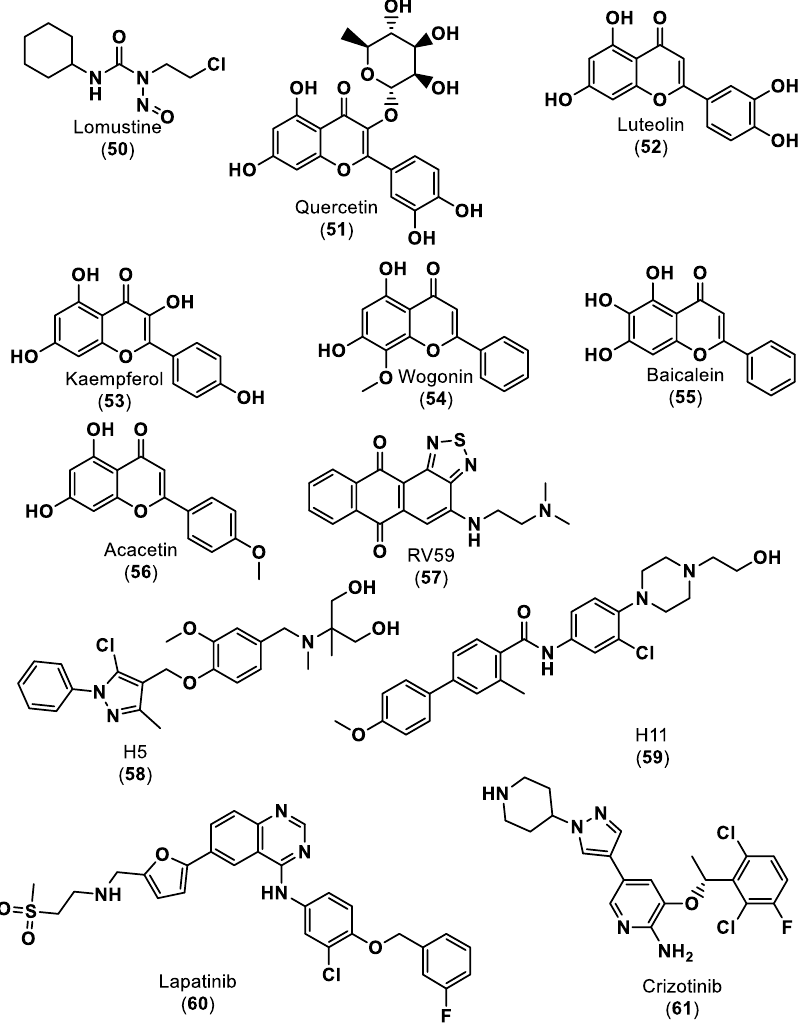
Figure 13. Small molecule ICIs predict targets that regulate PD-L1 expression [101–103,106,107].